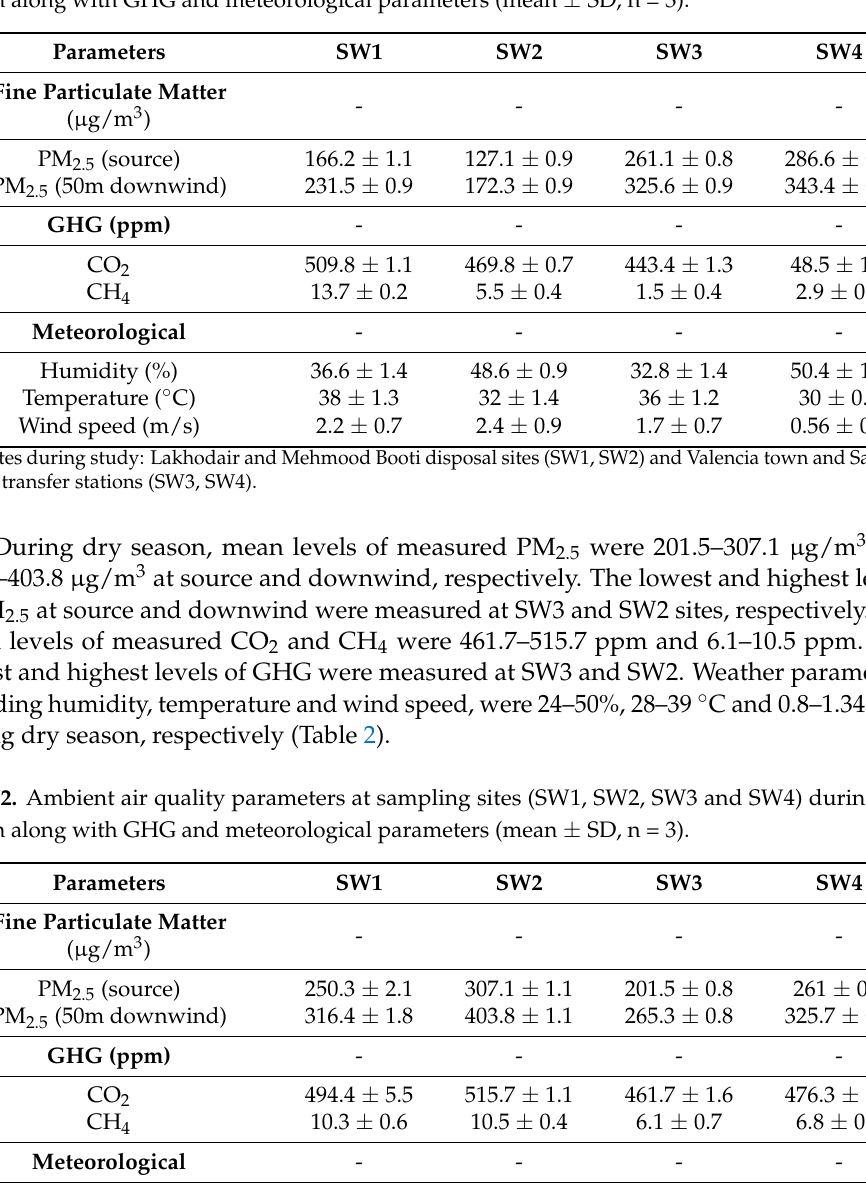
Table 1. Ambient air quality parameters at sampling sites (SW1, SW2, SW3 and SW4) during wet season along with GHG and meteorological parameters (mean ± SD, n = 3).